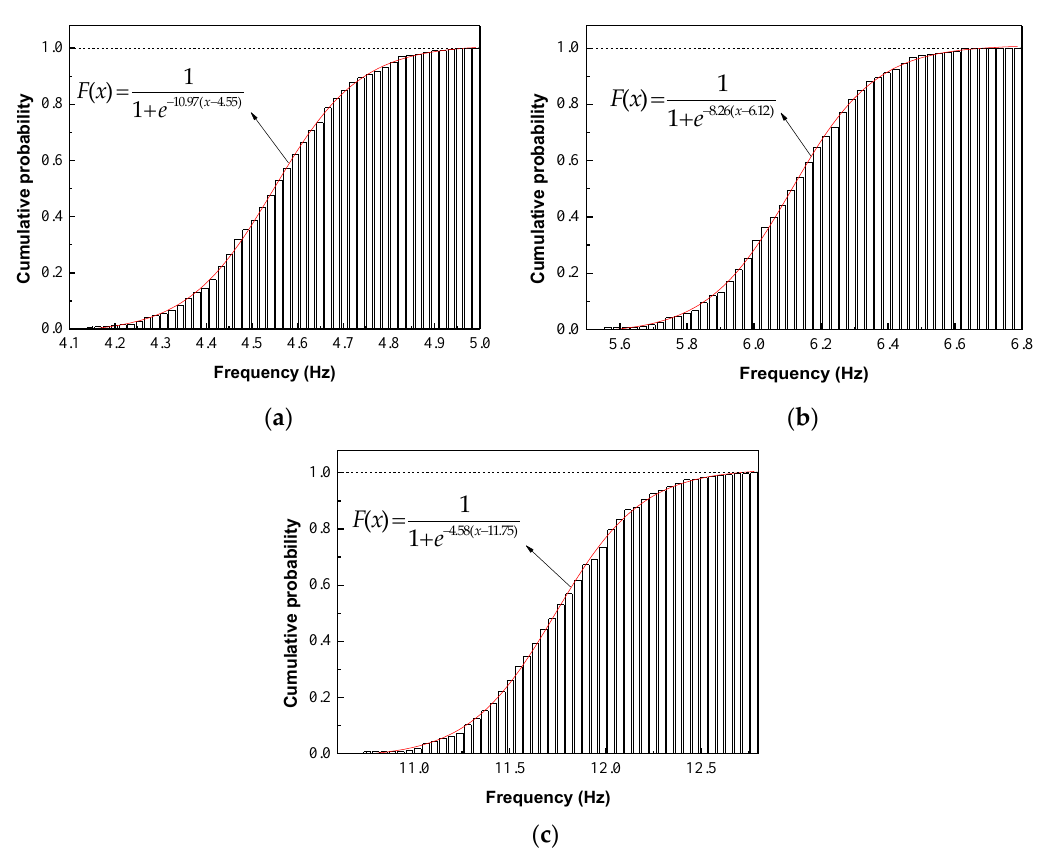
Figure 9. Cumulative distributions functions (CDFs) of the first natural frequencies of Model 1: ( a ) Initial guess; ( b ) 20th step; and, ( c ) 400th step (optimal).